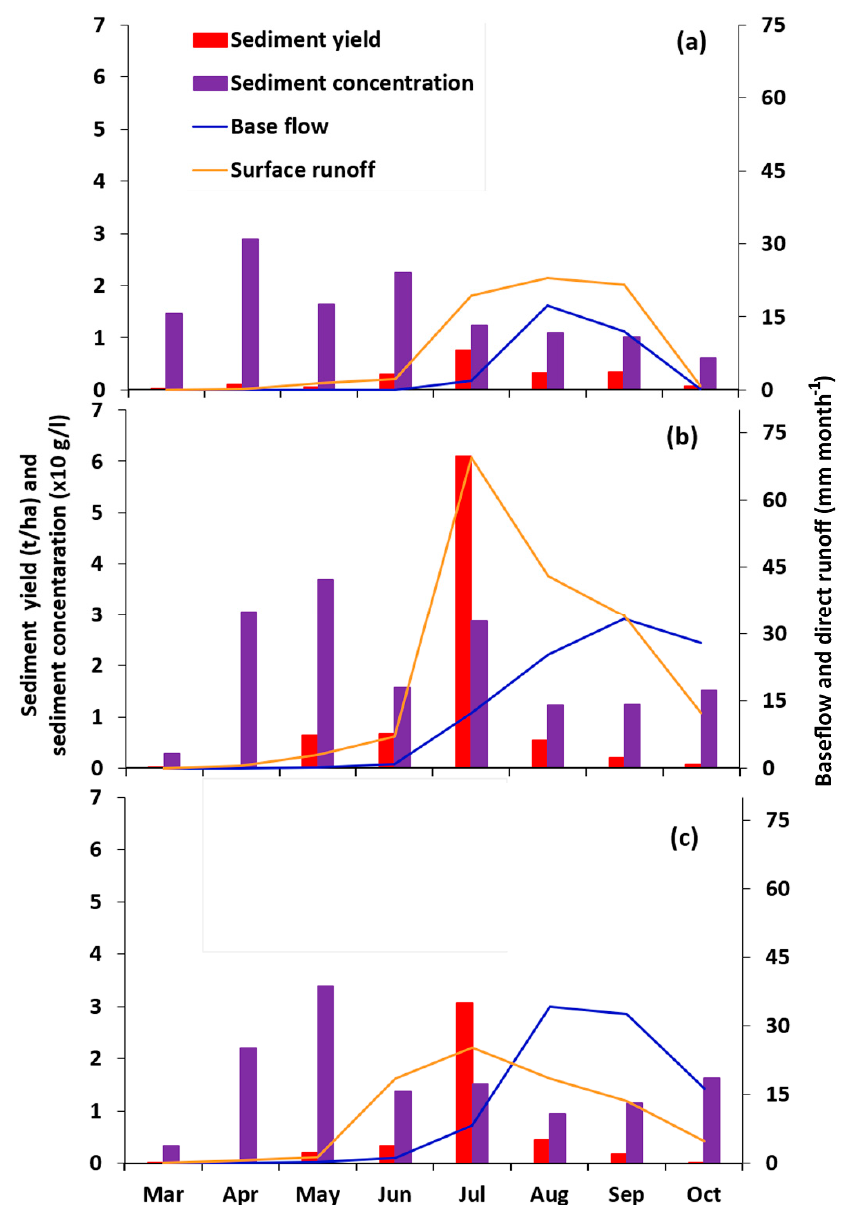
Figure 13. Mean monthly runoff, sediment yield, and concentrations of ( a ) forested watershed, ( b ) agricultural downstream watershed, and ( c ) the entire Gomit watershed.